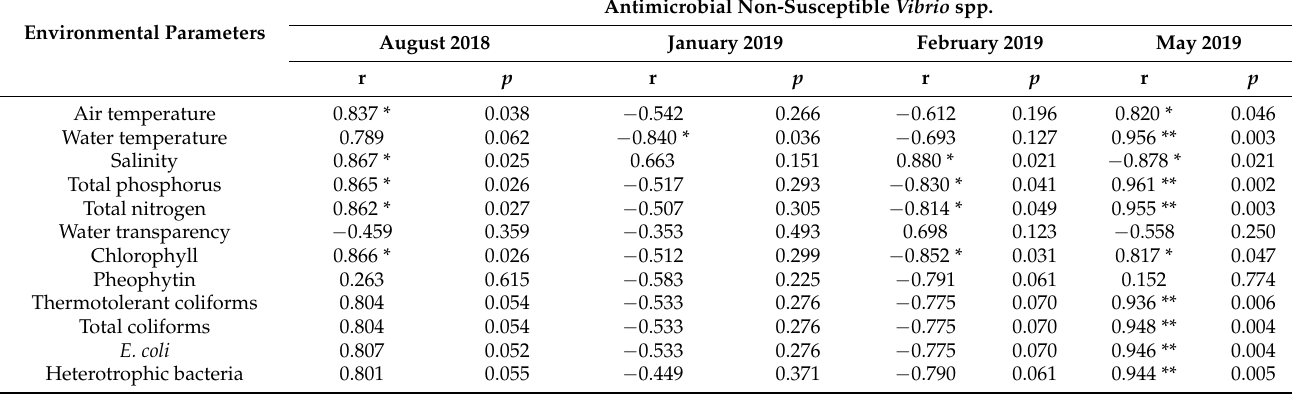
Table 4. Pearson’s correlations analyses between environmental parameters and antimicrobial non-susceptible Vibrio spp. abundances (CFU/mL) in four months. Antimicrobial Non-Susceptible Vibrio spp. Environmental Parameters